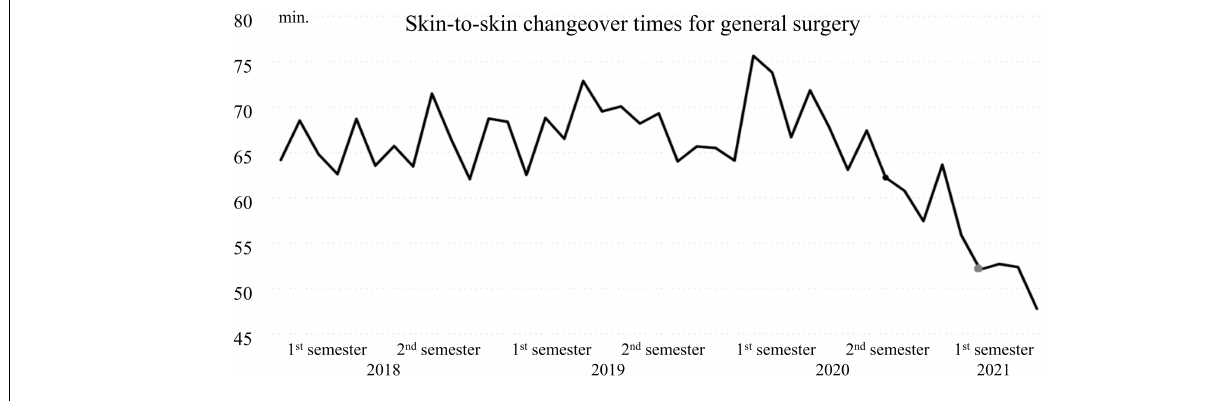
FIGURE 3 | Mean changeover time (min.) per month from January 2018 to May 2021 for general surgery.